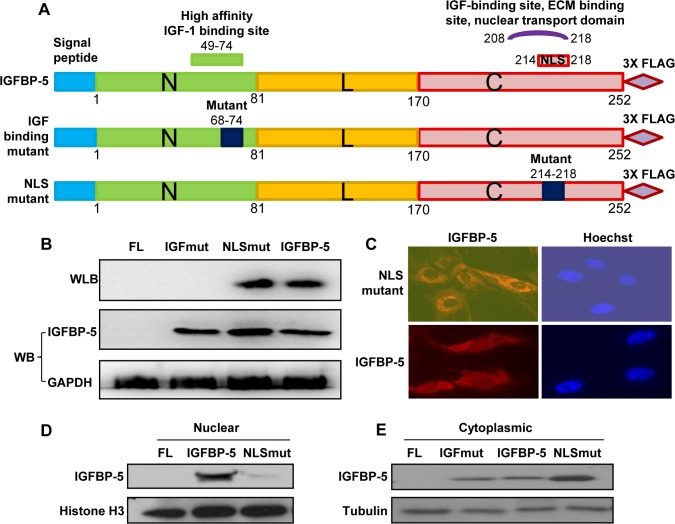
Generation of IGFBP-5 with mutated IGF binding and NLS domains and validation of the loss of function imparted by the mutations.(A) Schematic of wild type, IGF binding site-mutant, and NLS-mutant IGFBP-5 expressing constructs used for the generation of adenoviruses. (B) Confirmation that all three constructs result in IGFBP-5 production by western blotting and validation of the loss of binding to IGF of the IGF-binding site mutant using western ligand blotting. (C) The NLS-mutant IGFBP-5 does not translocate to the nucleus of primary human fibroblasts as detected using immunofluorescence. (D) The NLS-mutant IGFBP-5 is not detected in nuclear extracts of primary human fibroblasts expressing the indicated constructs, but its levels were higher in cytoplasmic fractions as detected following cellular fractionation and immunoblotting.